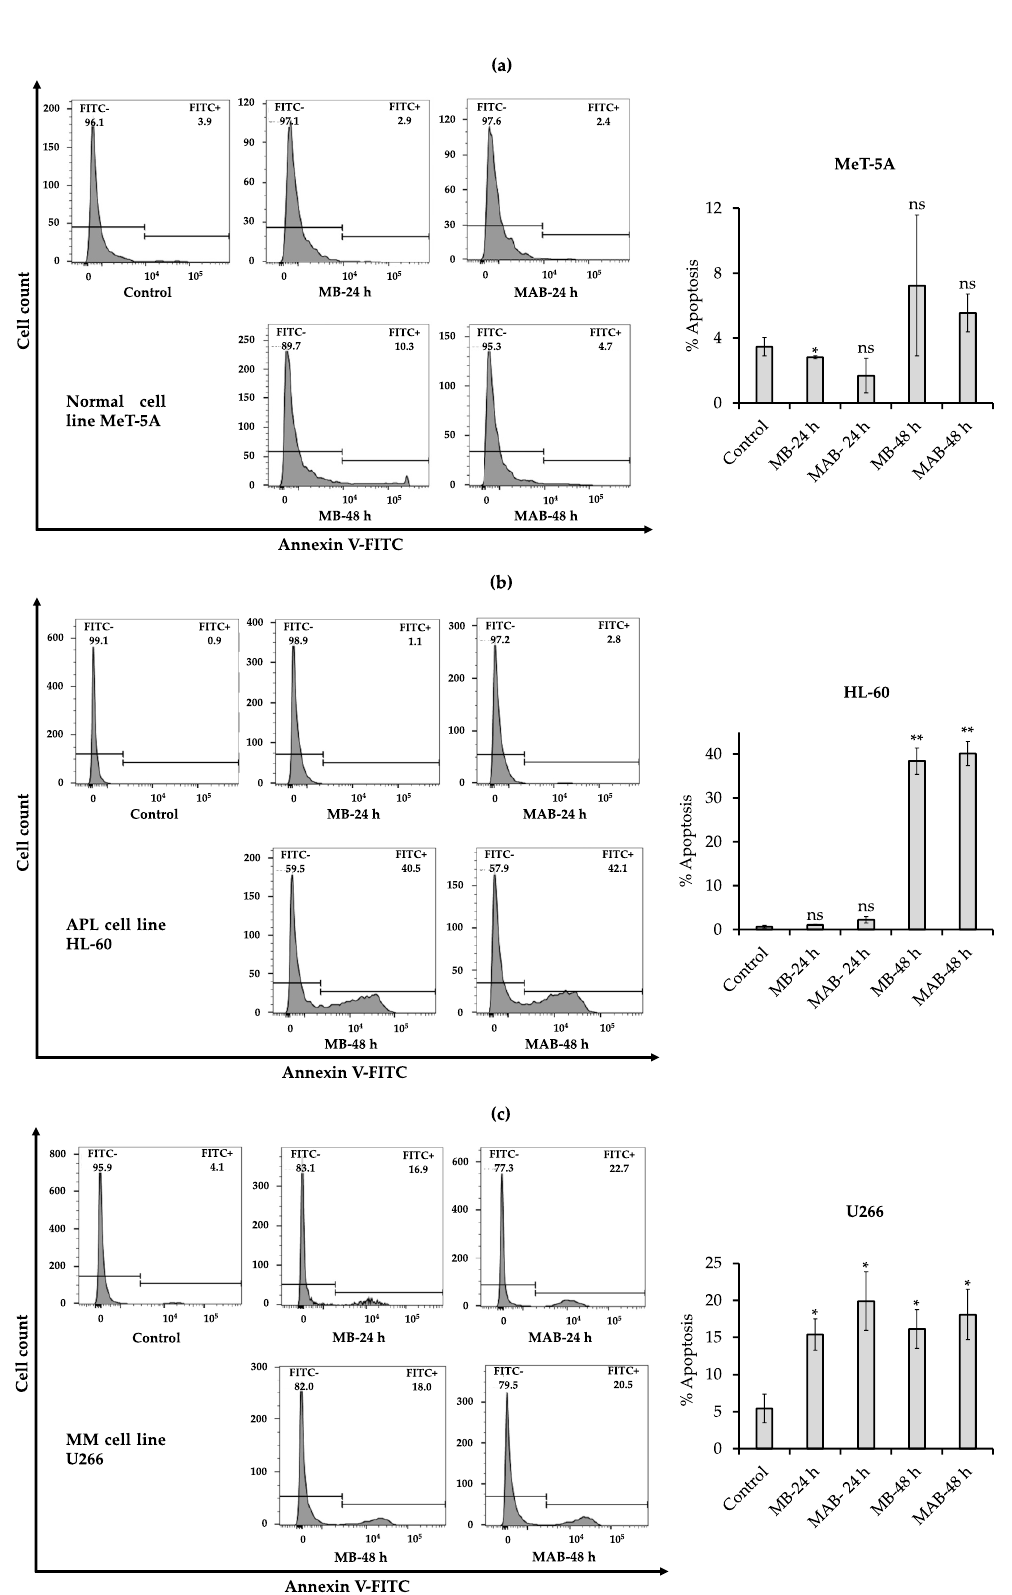
Figure 2. Apoptosis-inducing effects of momilactone B (MB) and the mixture of momilactone A and B (MAB) (1:1, w / w ) at 5 µ M against ( a ) non-cancerous MeT-5A, ( b ) acute promyelocytic leukemia (APL) HL-60, and ( c ) multiple myeloma (MM) U266 cell lines after 24 and 48 h. Statistical significance was determined by the t -test. * p < 0.05 versus control, ** p < 0.01 versus control. ns, not significant versus